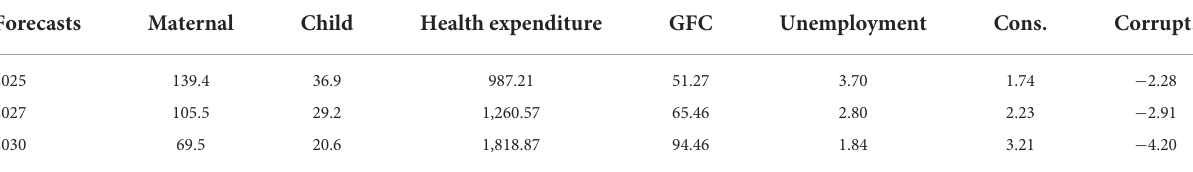
TABLE 2 The United Nations’ 2030 SDG health targets and forecasts of public health expenditures and non-health factors in SSA countries. Forecasts Maternal